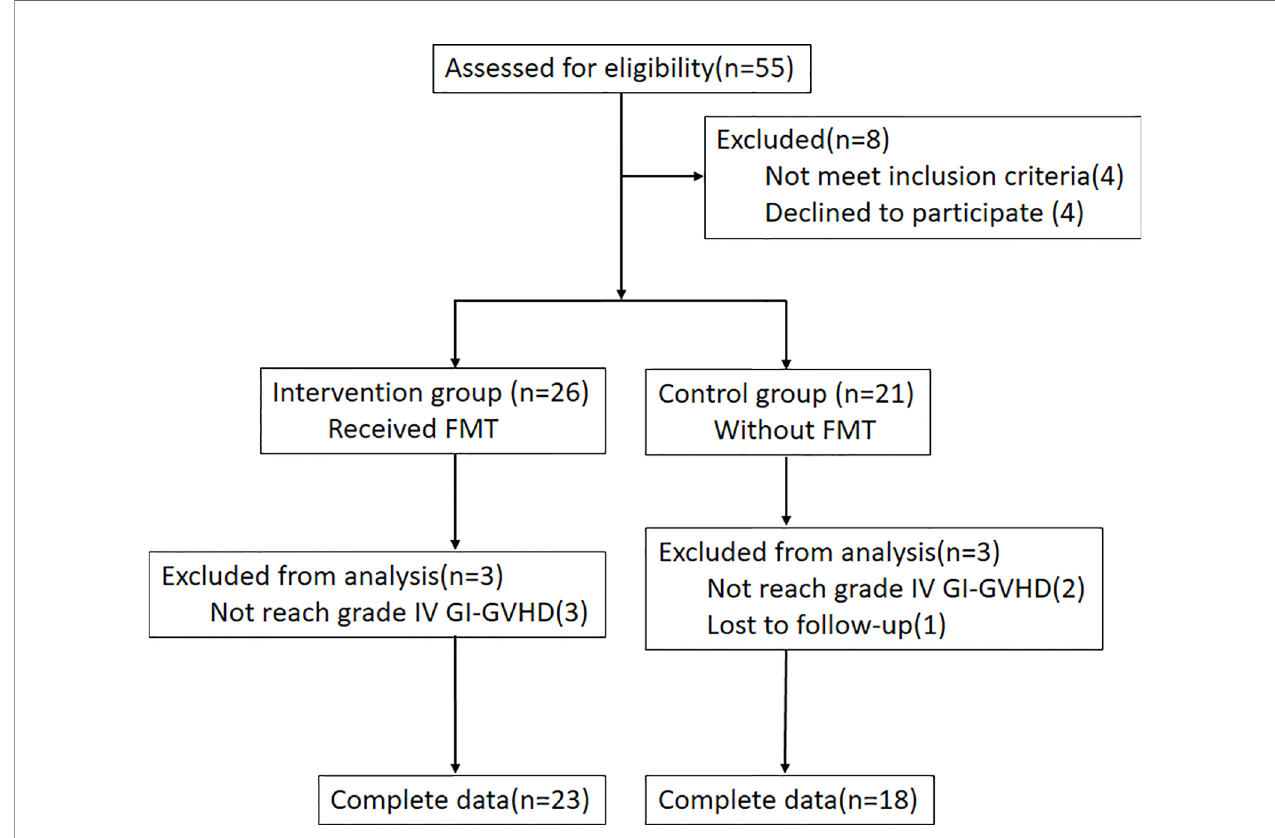
FIGURE 1 | Experimental fl ow